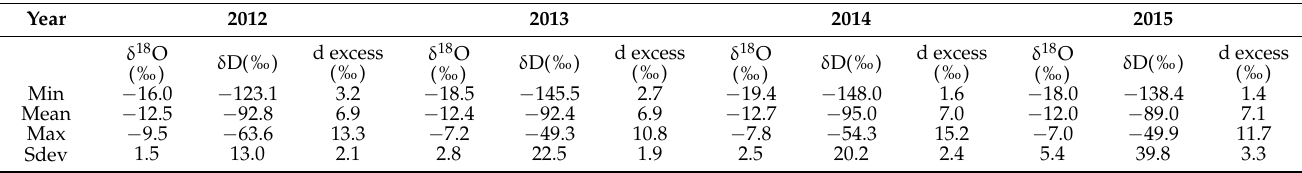
Table 4. Annual minimum, mean and maximum values and standard deviations of stable water isotopes of firn core OH-12 for the period 2012–2015 (January–December) calculated based on the weighted age